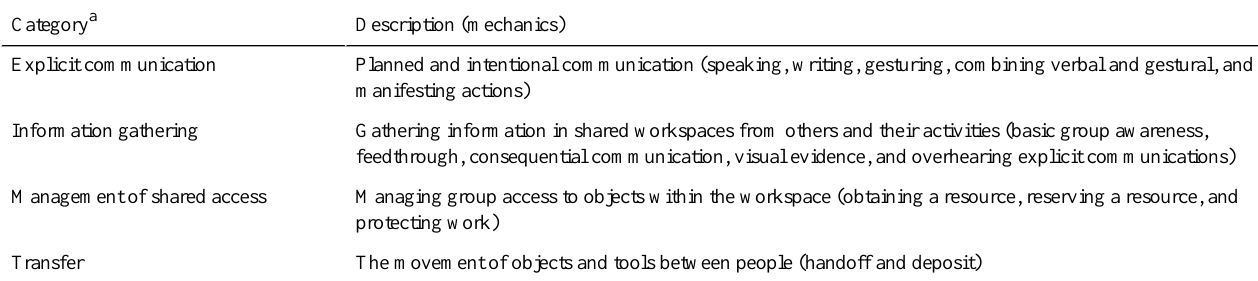
Table 3. Collaboration mechanics.